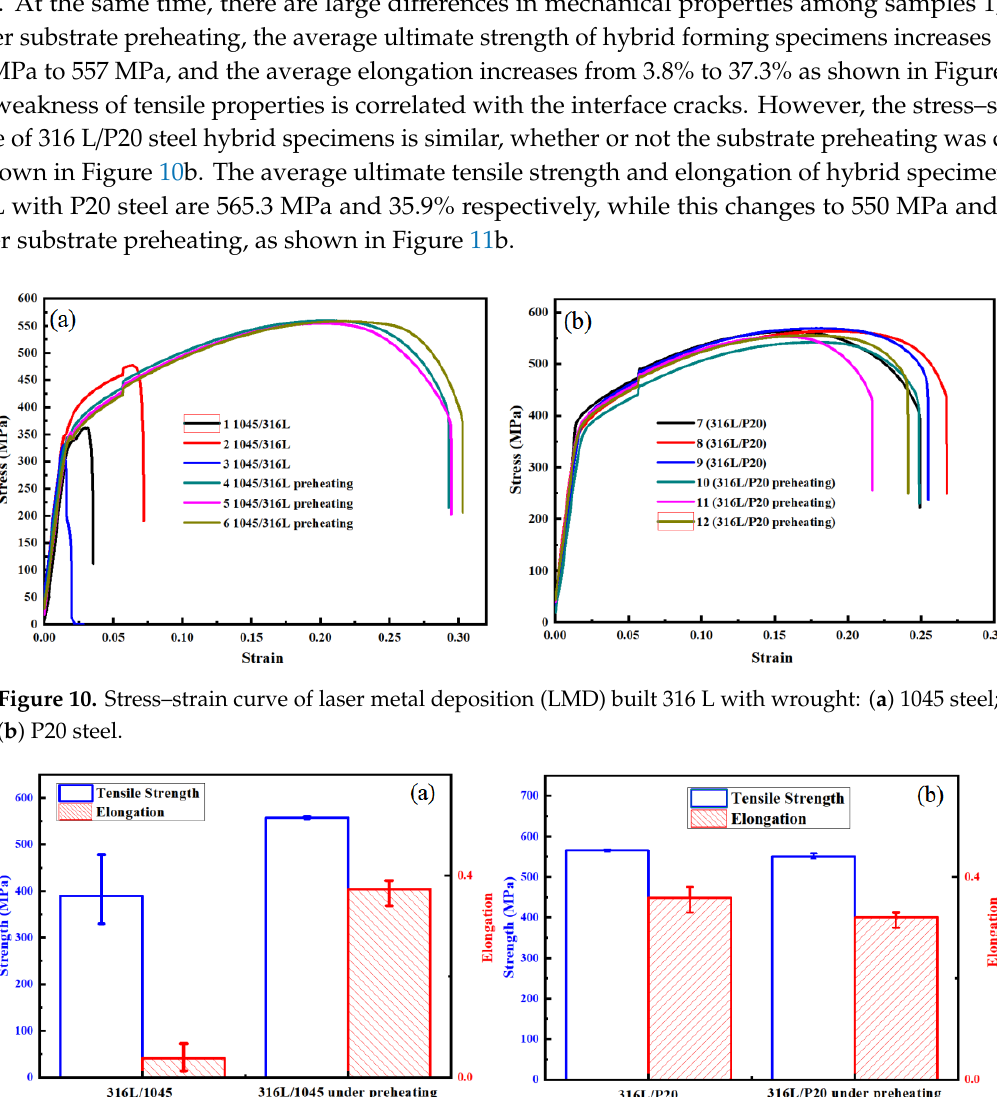
Figure 9. EDS map distribution of elements.